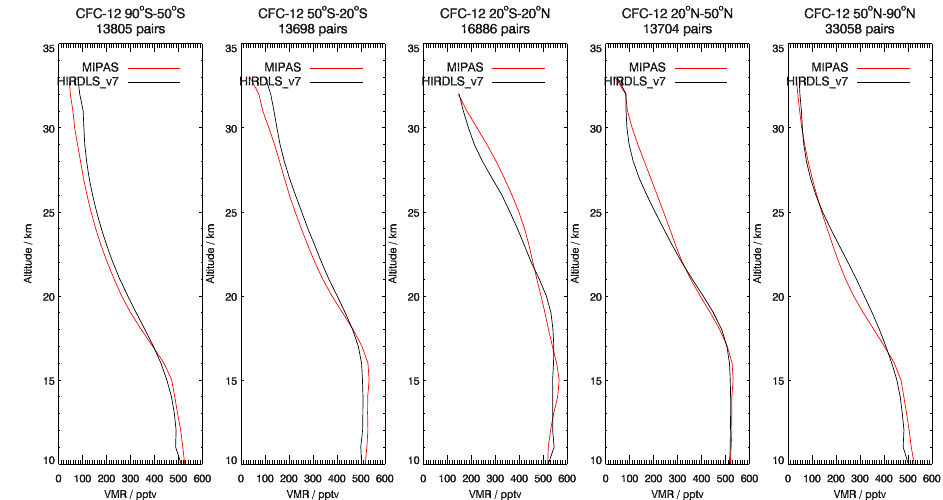
Figure A3. Comparison of mean profiles of MIPAS CFC-12 (red line) and HIRDLS (black line) for different latitude bins for the years of 2005–2008.